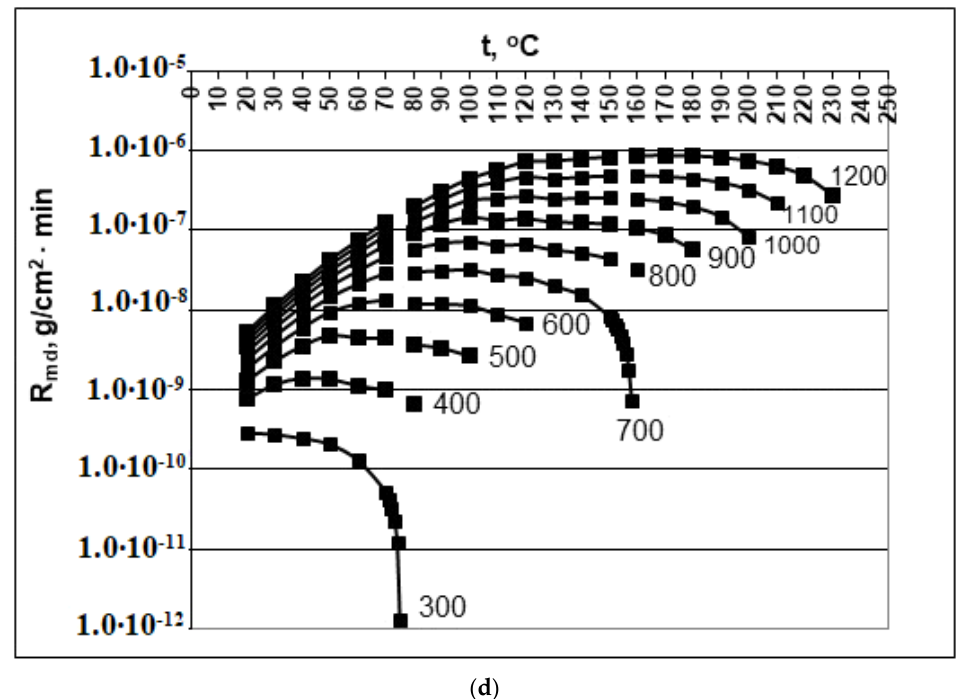
Figure 1. Dependence of the rate of molecular deposition R md (g/(cm 2 · min)) on the temperature t ( ◦ C) and concentration C s (mg/kg). ( a ) pH = 2.0; ( b ) pH = 4.0; ( c ) pH = 6.0; ( d ) pH = 8.0. C s = 300, 400, 500, 600, 700, 800, 900, 100, 110, and 1200 mg/kg.